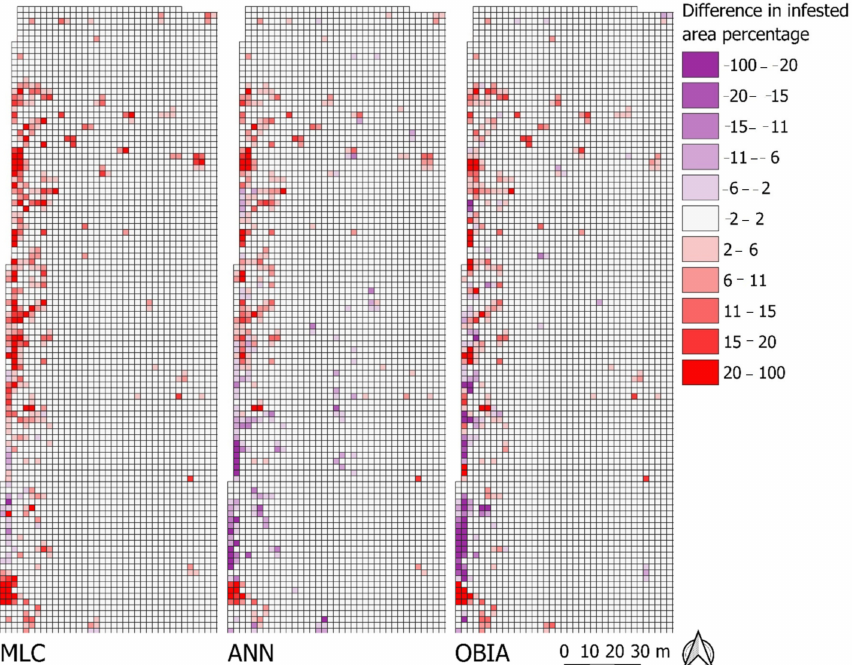
Figure 8. Comparison of the differences in weed area percentage per treatment cell for the three methods (detail).